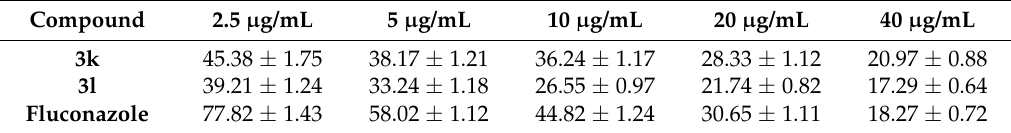
Table 2. Percentage ergosterol level of C. albicans (ATCC 10231) after treatment with compounds 3k and 3l and